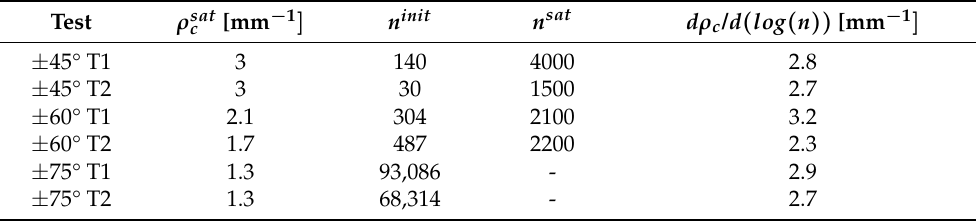
Table 3. Results of the crack detection. The cycle number to damage initiation n init , saturation n sat , and crack density growth rate in semi-logarithmic space d ρ c / d ( log ( n )) are listed to compare the